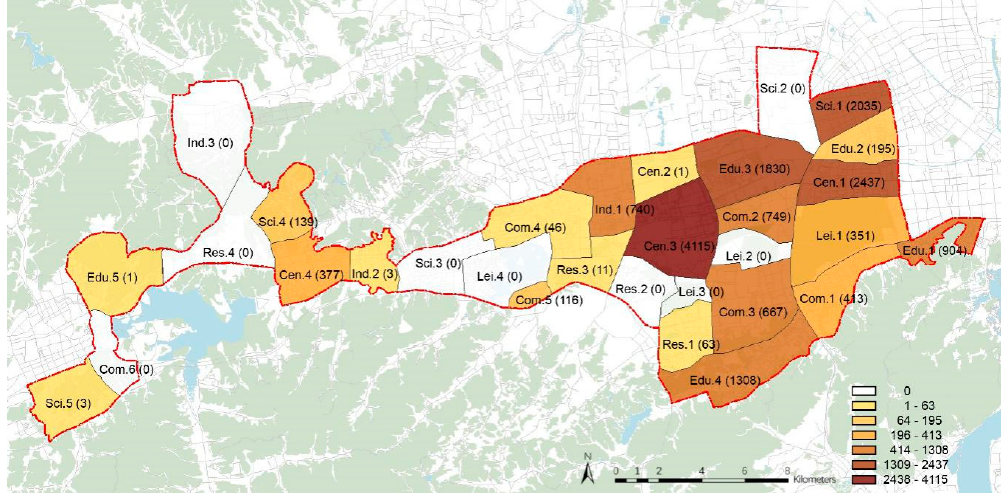
Figure 10. Distribution of sci-tech innovative enterprises of each area in the Corridor.